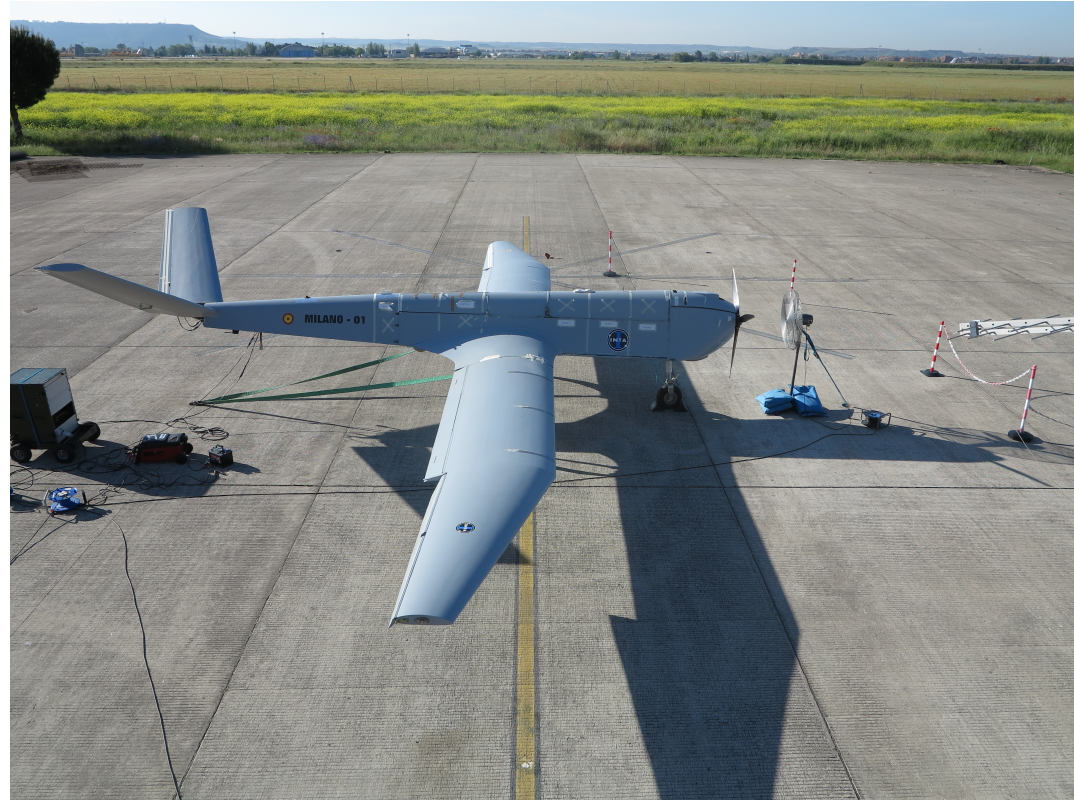
Figure 1. MILANO: a medium altitude long endurance remotely piloted aircraft system development at the National Institute for Aerospace Technology